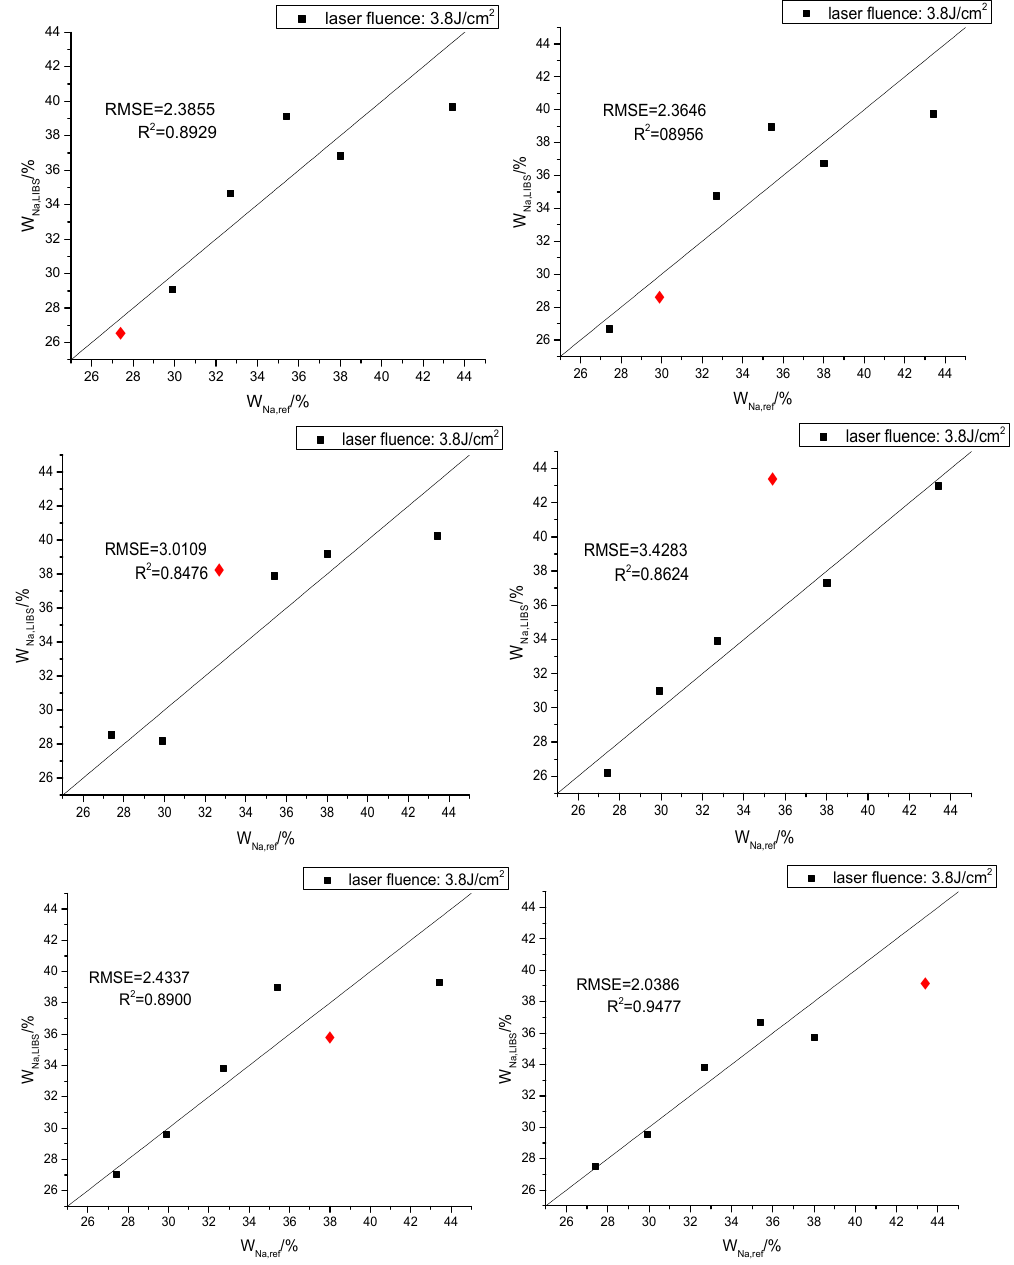
Figure 6. Results of Na data for Partial least squares regression (PLSR) (2 components).